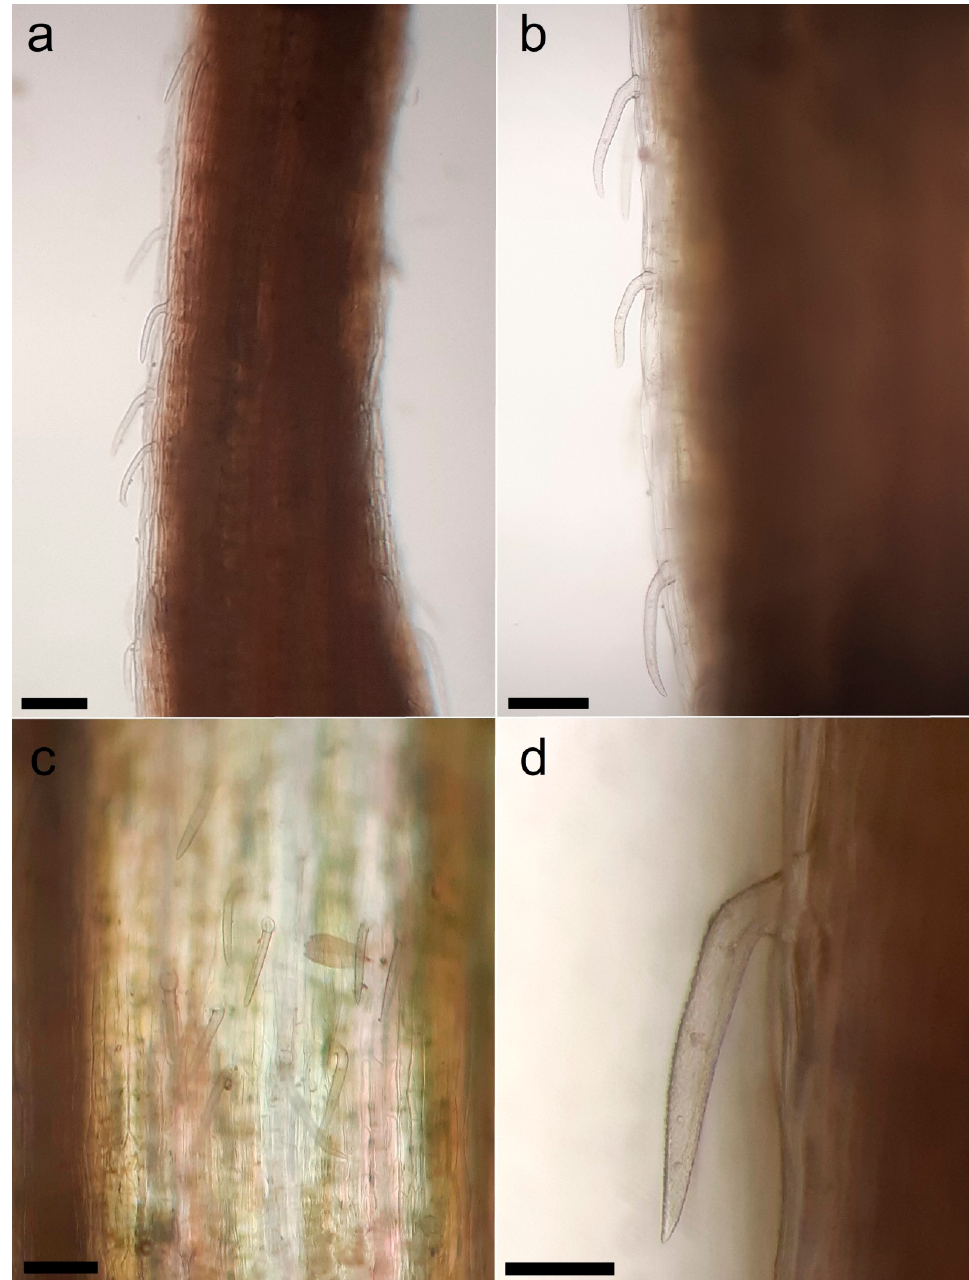
Figure 6. Section of the trichomal zone of the style ( a , b ) and hypanthium ( c , d ) of a flower of Oenothera speciosa . It is clear as the internal basal part of the hypanthium and the corresponding part of the style are densely pubescent, and the trichomes are oriented toward the base, with a thick wall and slightly sigmoid form. Scale bars: ( a,c ) 100 μ m, ( b ) 50 μ m, ( d ) 30 μ m. Photo credit: Andrea Bonifazi.